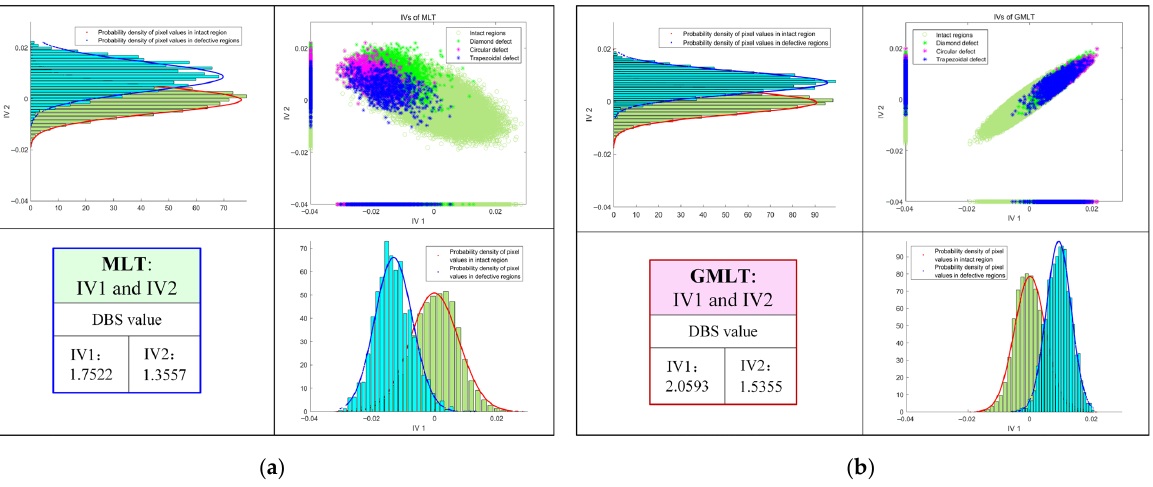
Figure 11. Pixel distribution and respective projections and their probability density plots in IV1 and IV2: ( a ) MLT; ( b ) GMLT. IV2: ( a ) MLT; ( b ) GMLT.